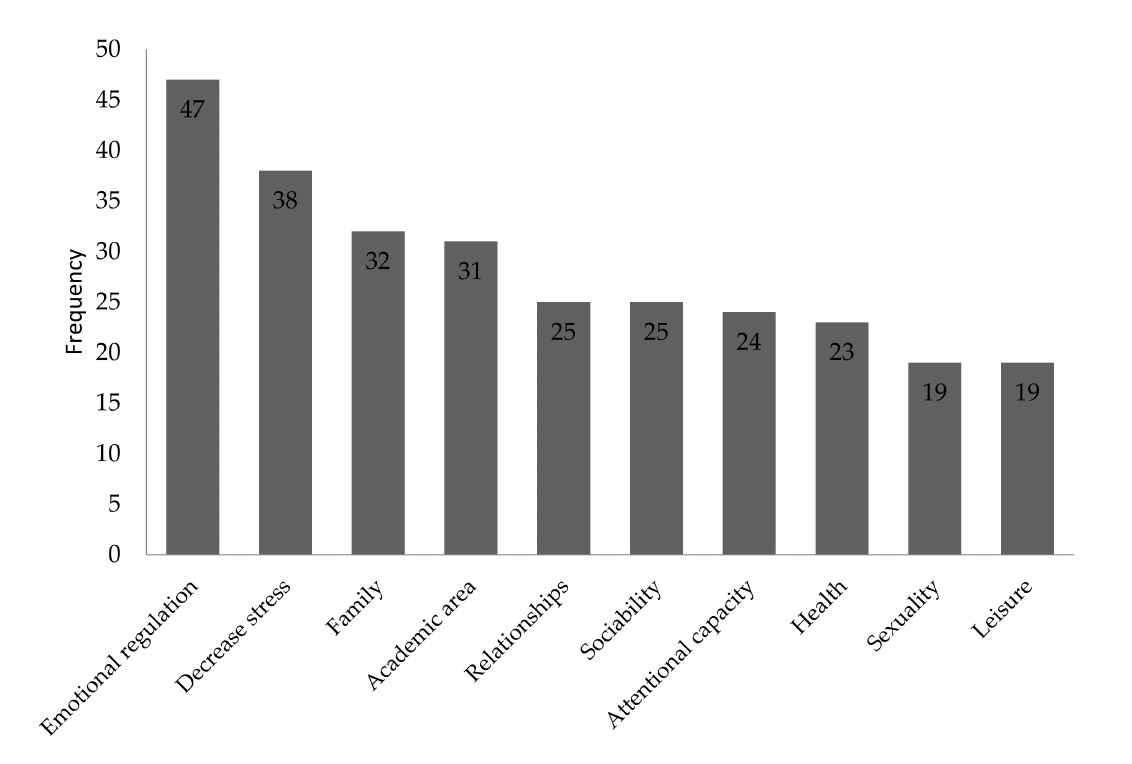
Figure 1. Increased areas with the practice of Mindfulness according to